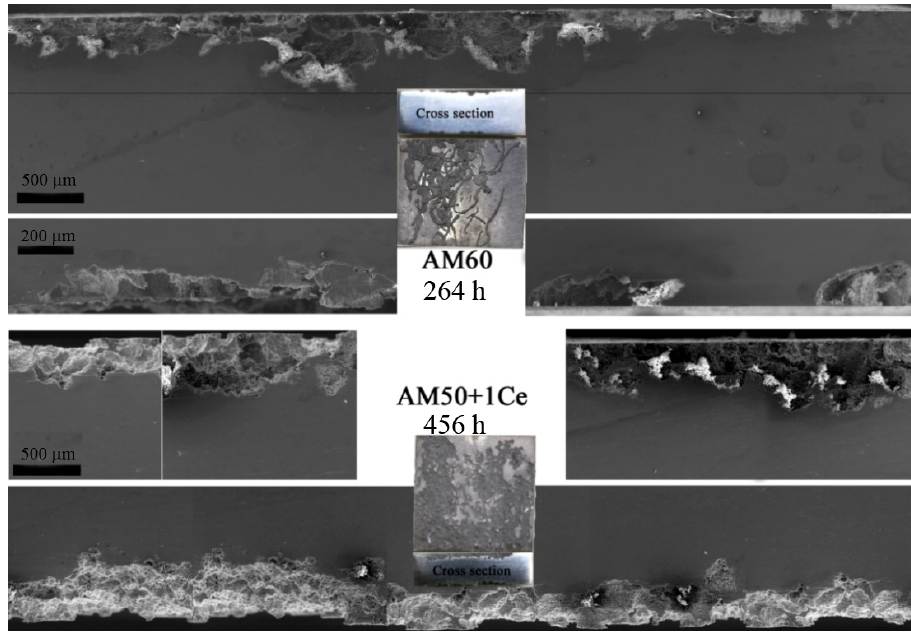
Figure 16. The cross-section corrosion morphology of HPDC AM50+1Ce and AM60 magnesium alloys immersed in 3.5wt% NaCl solution for 456 and 264 h.